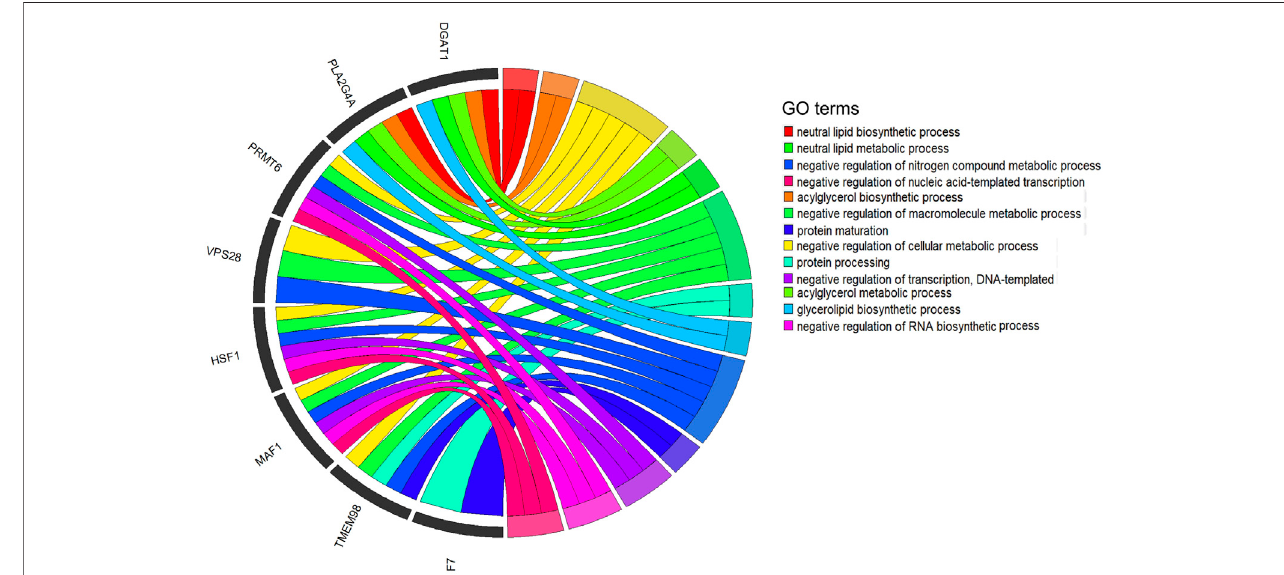
FIGURE 5 | Signi fi cant Gene Ontology (GO) terms enriched by the genes within 200 kb of signi fi cant SNPs. After quality control, 13 GO terms that are enriched by eight genes are revealed in the circus plots ( p < 0.05).